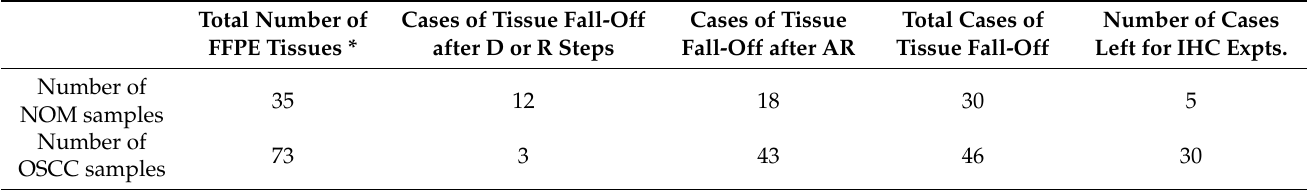
Table 3. Documentation of cases of tissue section fall-off from slides during sample processing steps for immuno- histochemical staining experiments for a period of 1 year (2019–2020) for FFPE tissues.